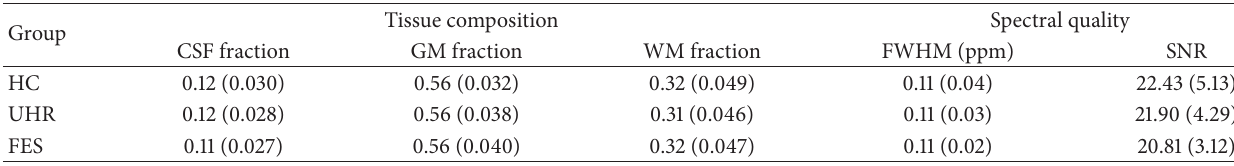
Table2:Means(SD)fortissuecompositionandspectralqualityinthemPFCregioninfirst-episodeschizophrenia(FES),subjectsatultrahigh risk for psychosis (UHR), and healthy controls